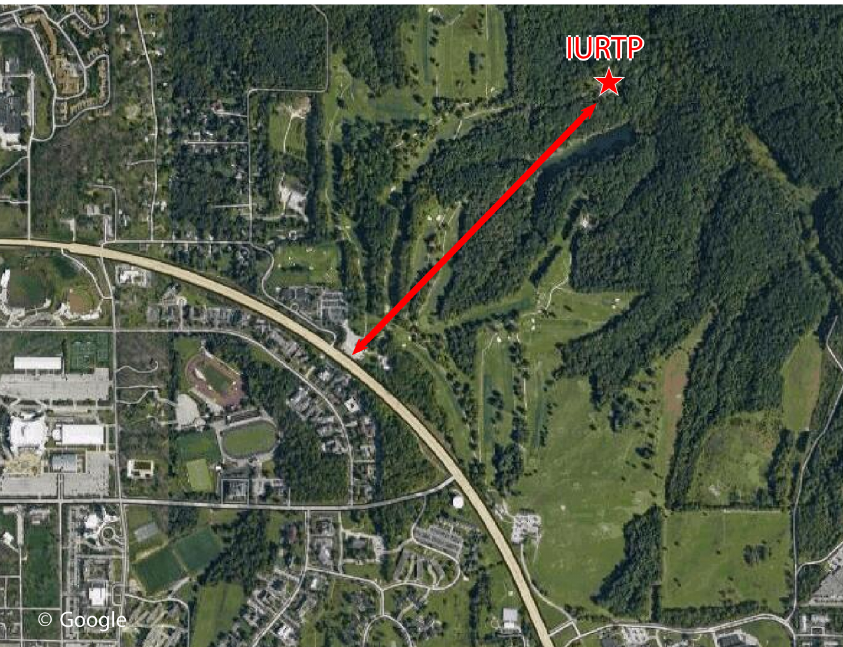
Figure 1. Map of the sampling site. The star symbol represents the Indiana University Research and Teaching Preserve (IURTP) in Bloom- ington, Indiana, USA. The arrow represents a distance of